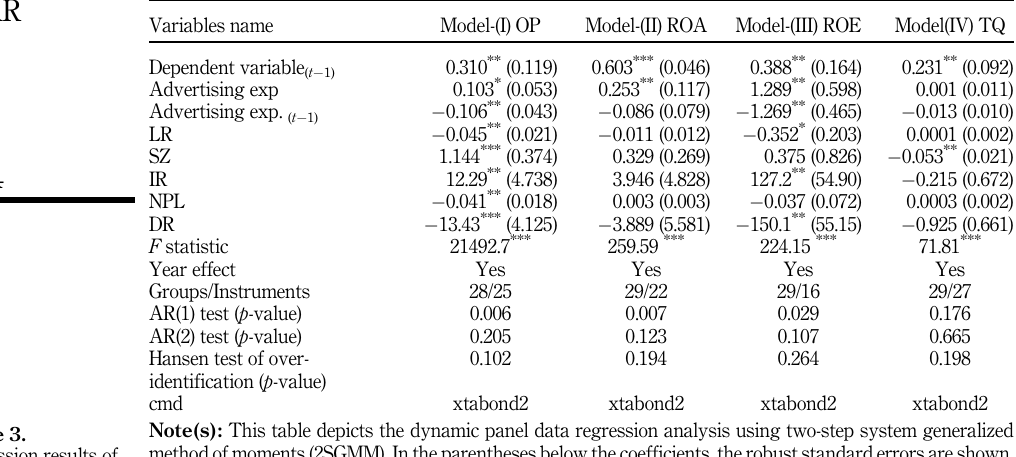
Table 3. Regression results of analysis using two- step system